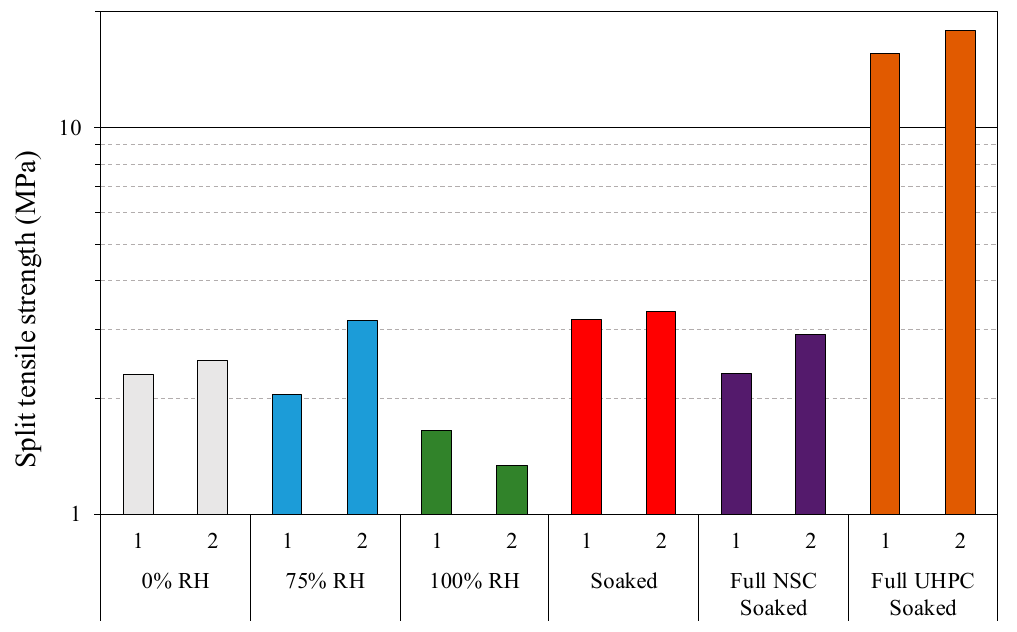
Figure 4. Split tensile strength (T) for each humidity exposure.